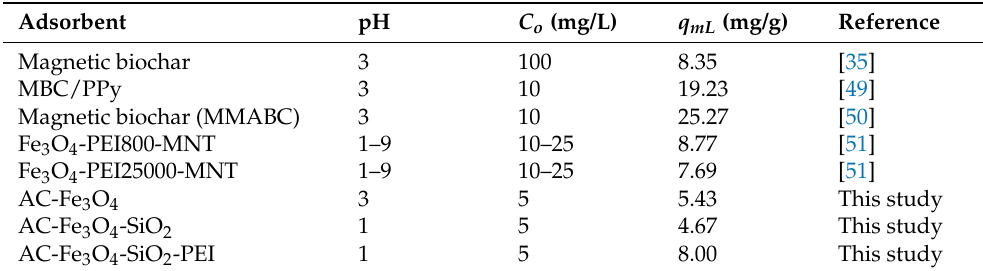
Table 4. Comparison of adsorption capacities of Cr(VI) by different adsorbents as to AC-Fe 3 O 4